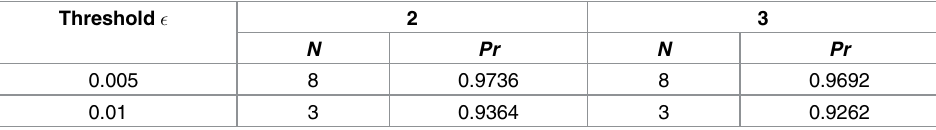
Table 12. Common P : Concentration measurefor ~ p ð i Þ